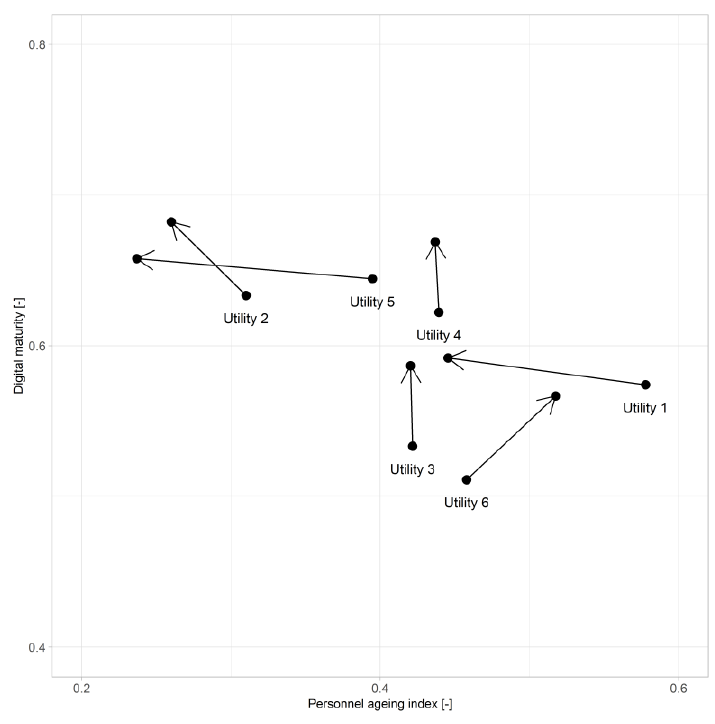
Figure 4. Digital maturity (0 – 1) versus Personnel Aging Index (0 – 1). Table 4. Details of the digital maturity survey given to AGS utilities.